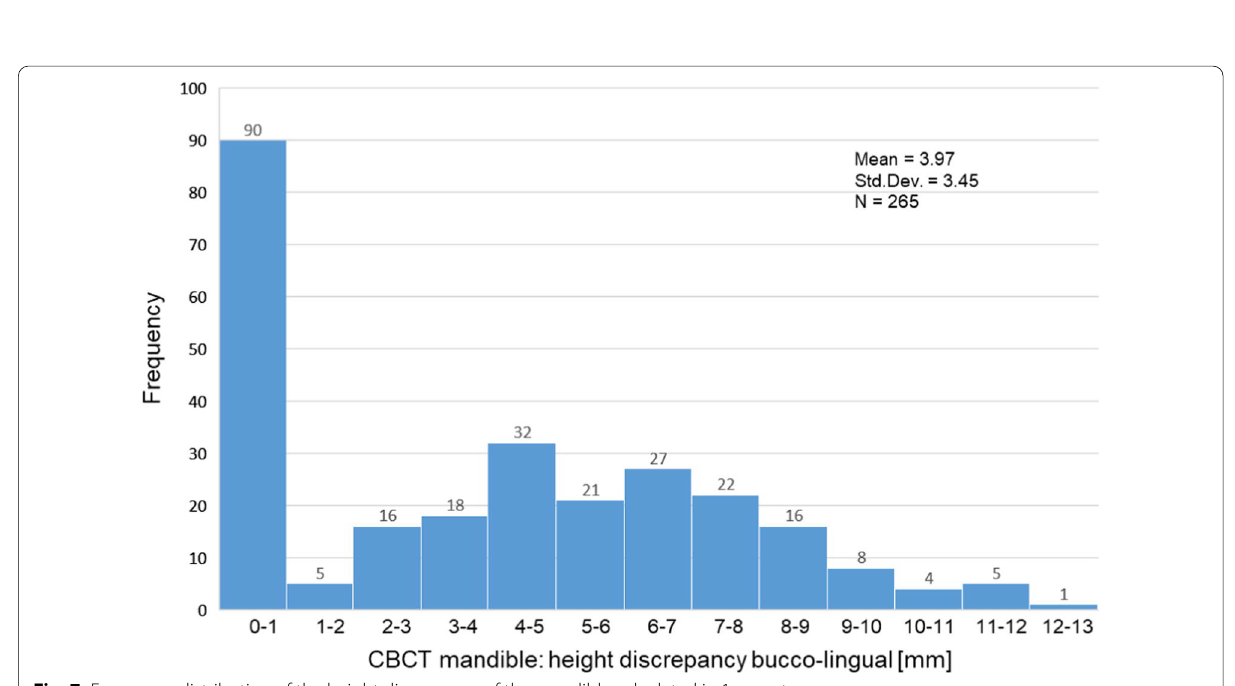
Fig. 7 Frequency distribution of the height discrepancy of the mandible calculated in 1‑mm